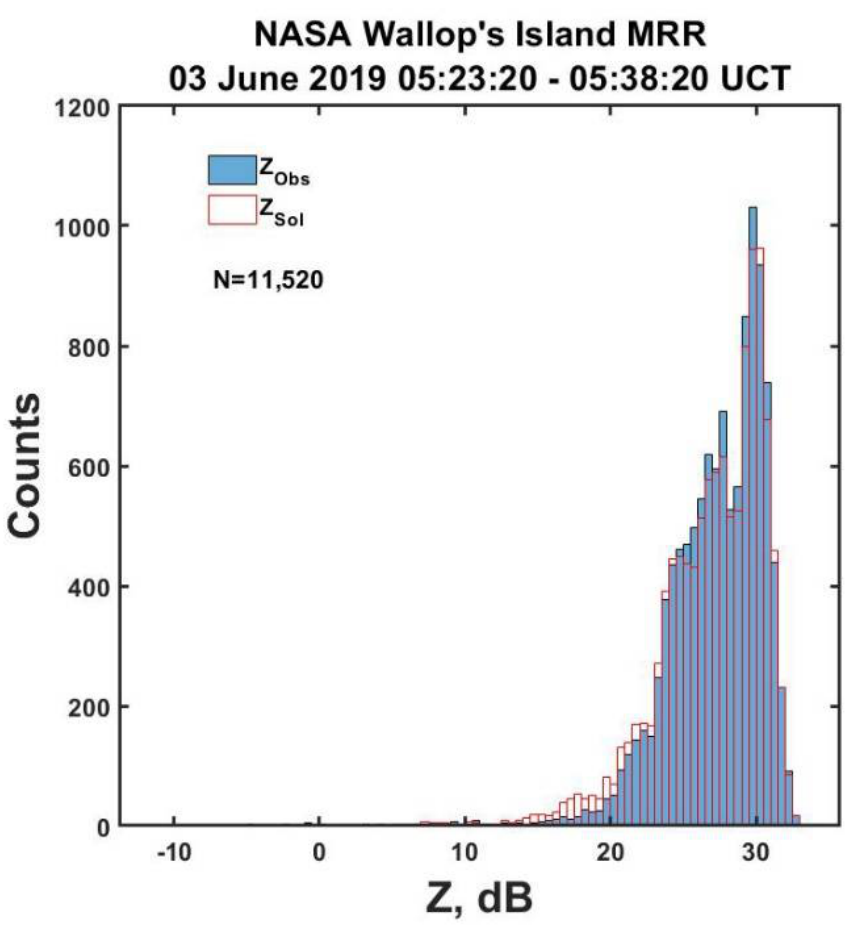
Figure 10. Histograms of the MRR measured (subscript Obs, solid bars) and of the solution (subscript Sol, red empty bars) radar reflectivities in Figure 8 showing the excellent matching, suggesting the general validity of the solutions.